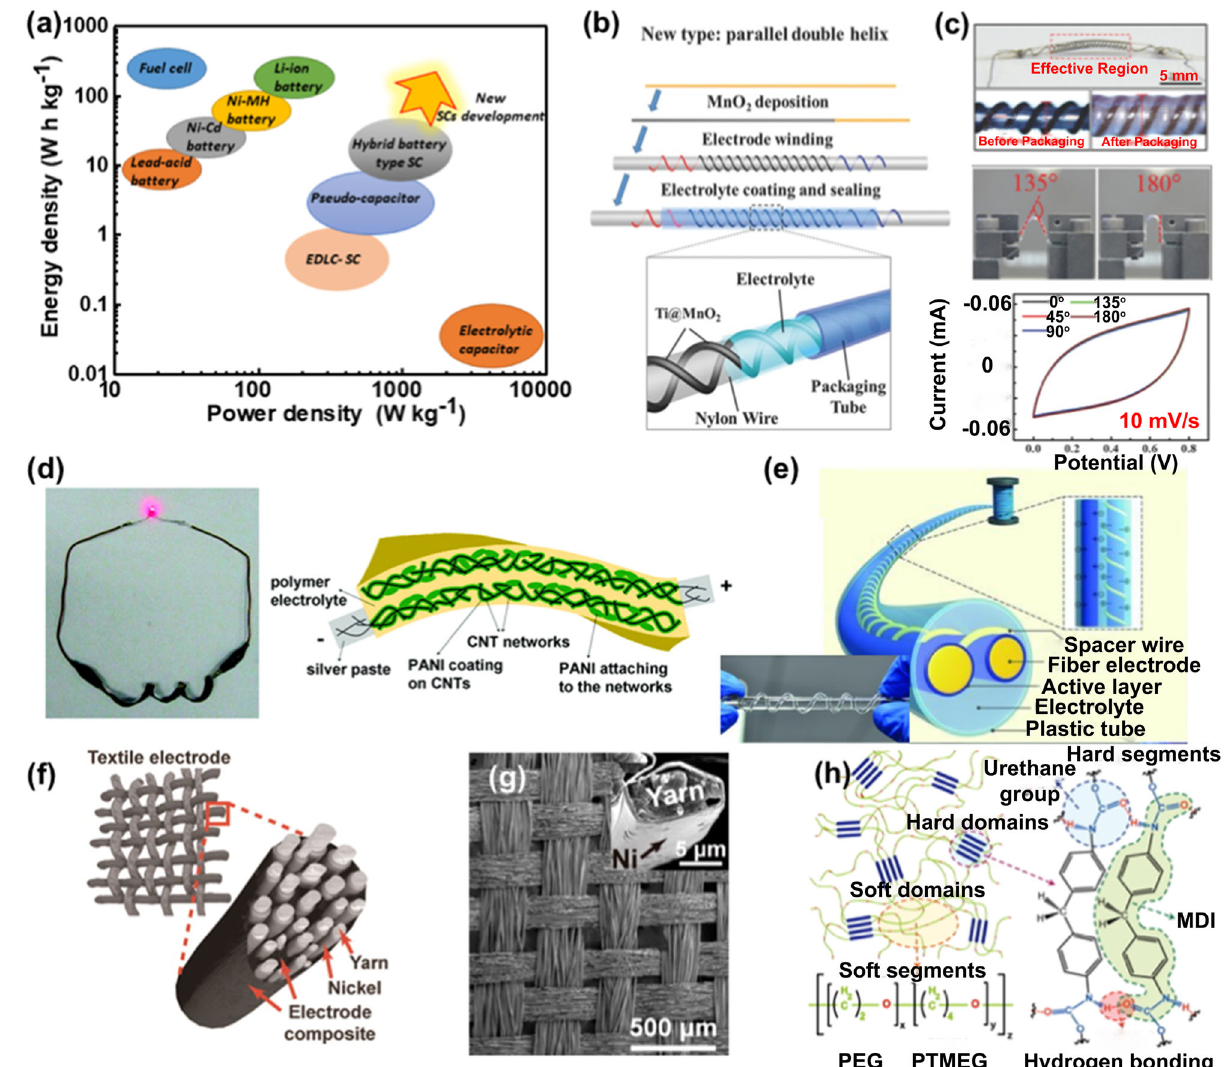
Fig. 7 Energy storage devices. a Comparison between batteries and SC technologies performance. b 3D schema of wire-shaped SCs. c Flexible wire-shaped SC characterized under different bending conditions. Reprinted with permission from Guo et al. 158 Copyright © 2016, John Wiley and Sons. d Photograph (left) and 3D schema (right) of CNT-based stretchable SC. Reprinted with permission from Meng et al. 161 Copyright © 2010, American Chemical Society. e 3D schema and photograph (inset) of a fl exible SC packaged using plastic tube. Reprinted with permission from Fu et al. 164 Copyright © 2012, John Wiley and Sons. f 3D schema and g SEM image of woven battery electrode yarns, consisting of multiple strands coated by Ni and battery composite. Inset: a cross-sectional SEM image of the Ni-coated textile. h 2D schema of the PU molecular structure, highlighting hard and soft domains in PU. Reprinted with permissions from Lee et al. 166 Copyright © 2013, American Chemical